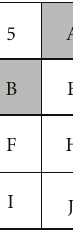
Figure 7: A processing order example for